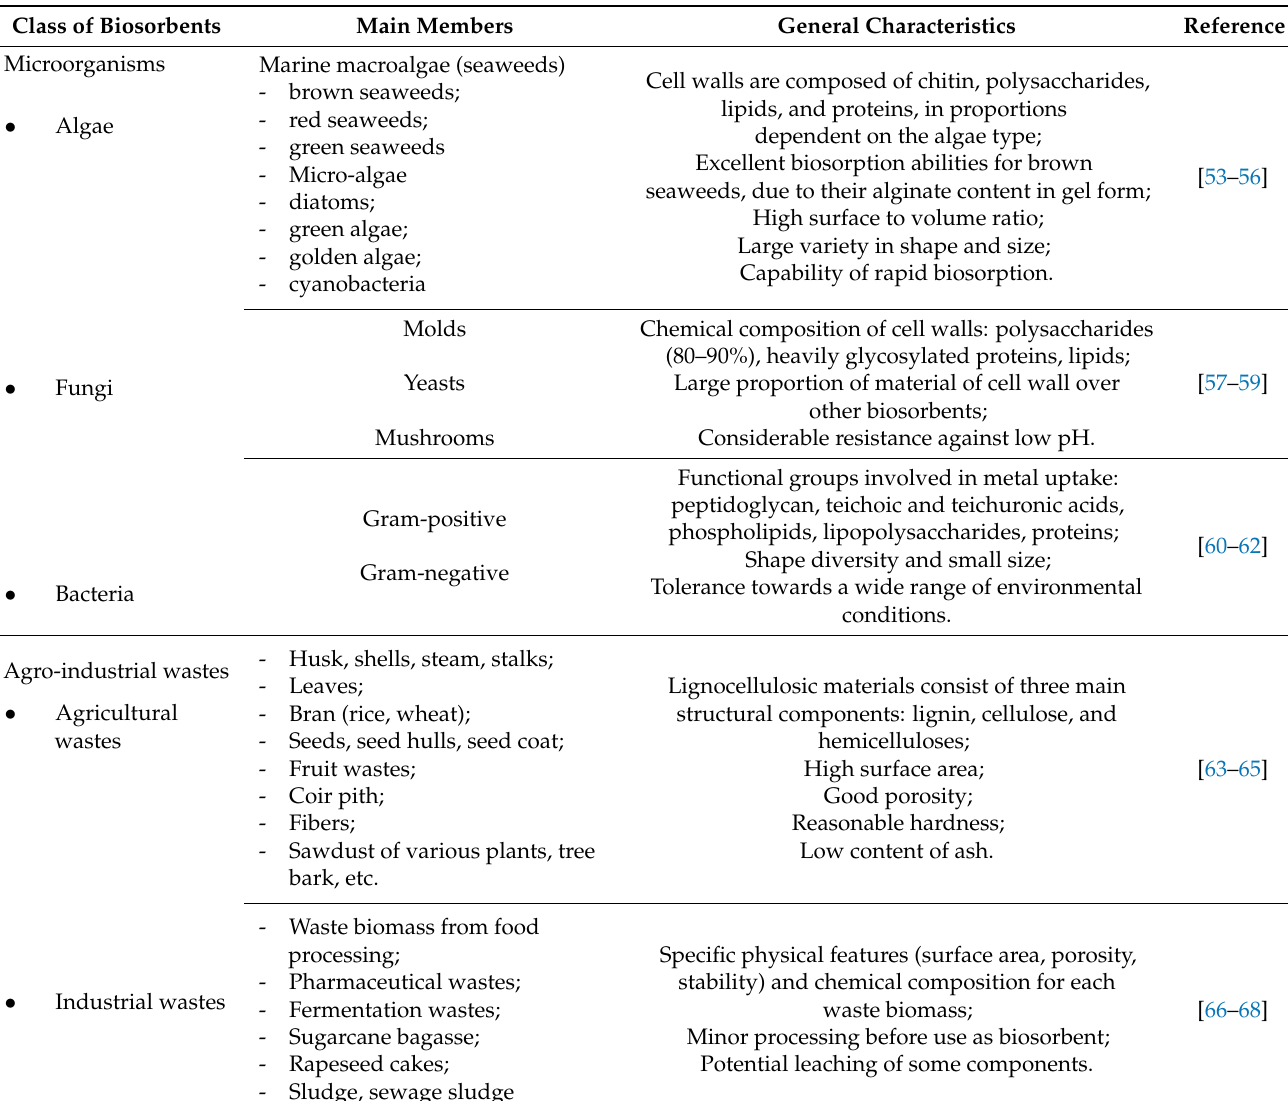
Table 1. Focus on the most targeted biosorbents of heavy